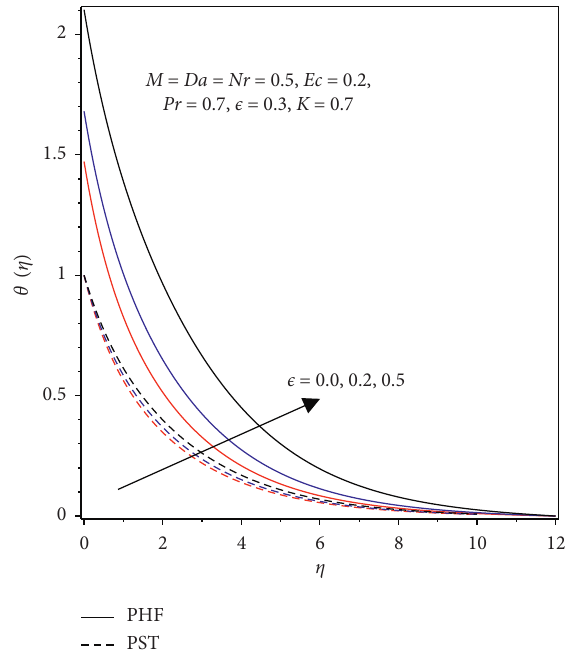
Figure 5: Variation of Darcy term Da on temperature